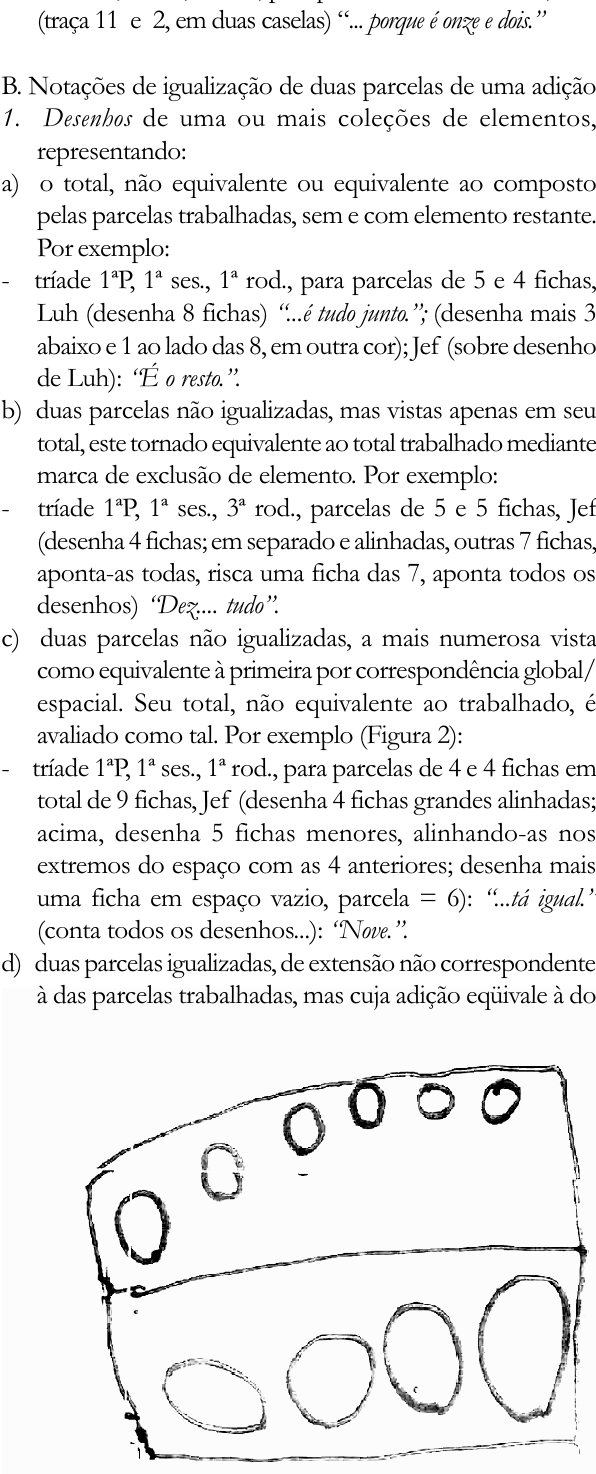
Figura 2 . As parcelas igualizadas 6